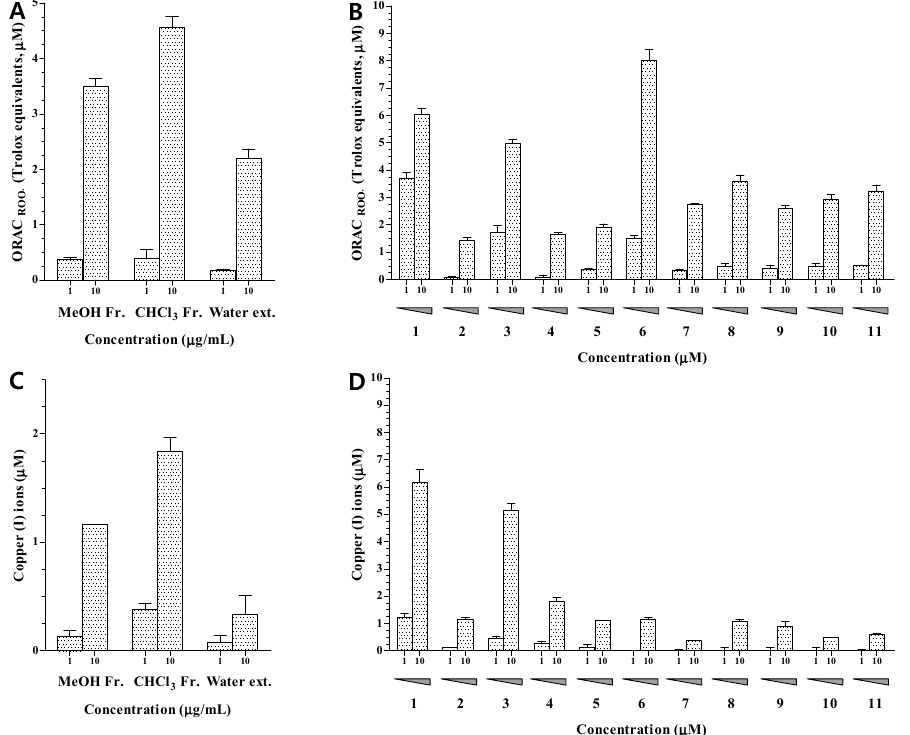
Figure 3. Peroxyl radical-scavenging capacity (( A , B )) and reducing capacity (( C , D )) of the extracts and compounds 1 – 11 from H. erinaceum . Data are expressed as the mean ± standard deviation of three individual experiments. Statistical significance is determined by one-way ANOVA followed by Dunnett’s multiple comparison test ( p < 0.05).